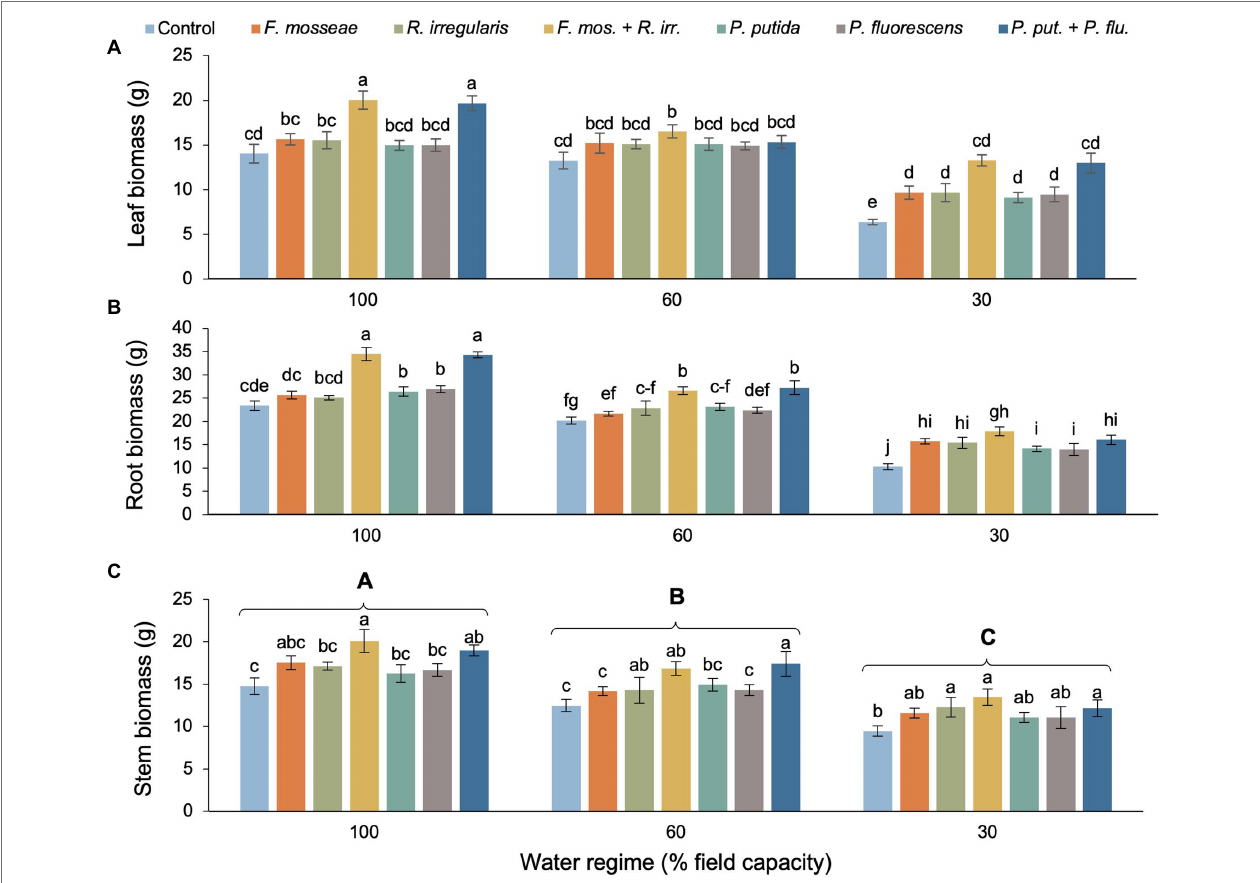
FIGURE 1 | Effect of water regime and soil microbial inoculation on the biomass allocation of Myrtus communis seedlings. For leaf biomass and root biomass there was a significant water regime × inoculation treatment interaction ( Table 2 ), hence different lower-case letters indicate statistically significant differences across the 21 treatment combinations. For stem biomass, only the main effects of water regime and inoculation treatment were significant ( Table 2 ), thus upper-case letters indicate a significant difference between different levels of drought stress and lower-case letters indicate a significant difference between different inoculation treatments within a water regime (Duncan’s new multiple range test, α =